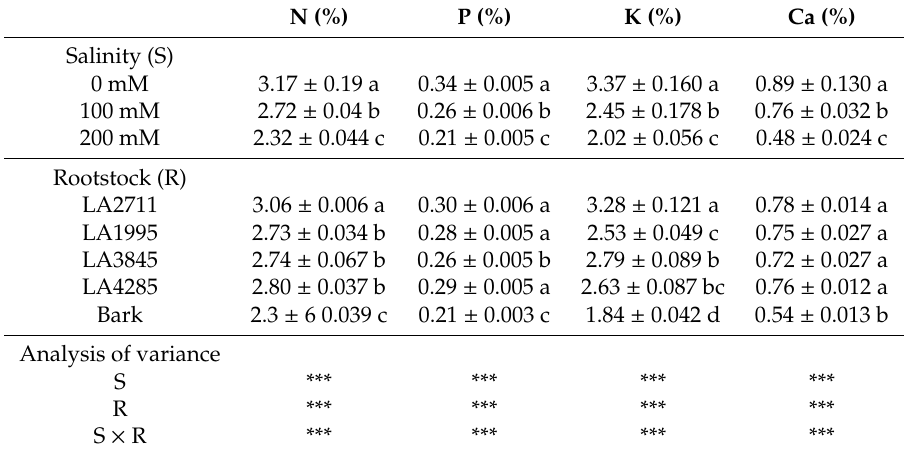
Figure 6. Effect of salinity levels × rootstocks interaction on ( A ) N, ( B ) P, ( C ) K and ( D ) Ca. Vertical bars represent standard errors of means ( n = 3); in each bar, values followed by different letters differ significantly at p = 0.05 according to Tukey test. Table 9. E ff ect of salinity treatments, rootstocks and their interactions on the minerals of the tomato